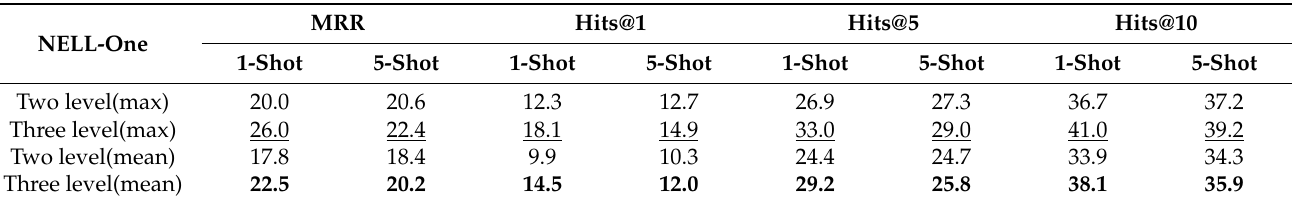
Table 3. Performance results for different debilitating attention layers. The underlined numbers represent the best results for the highest performance in the model, and the bold numbers represent the best results for the average performance.